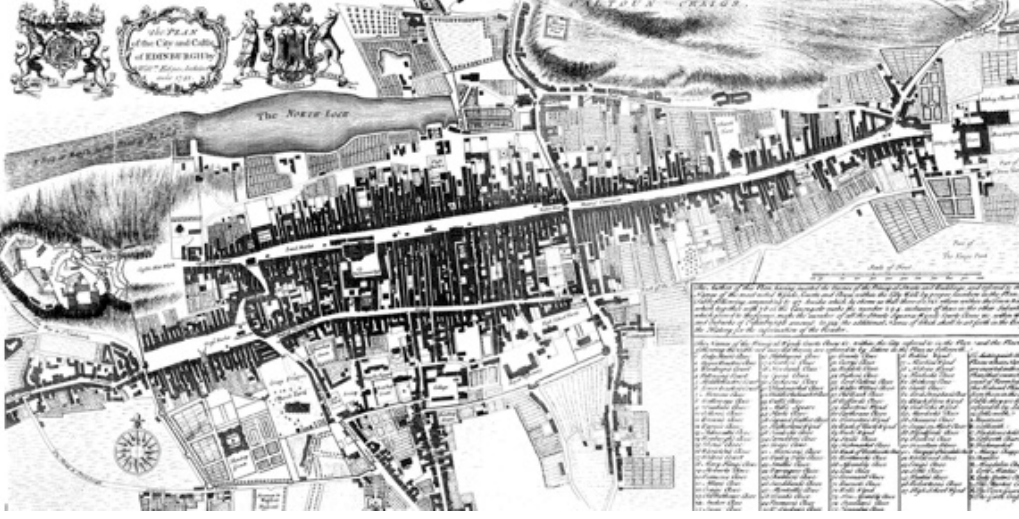
Figure 1. William Edgar, Plan of the City of Edinburgh, 1765. Source: National Library of Scotland. https://maps.nls.uk/towns/rec/312.